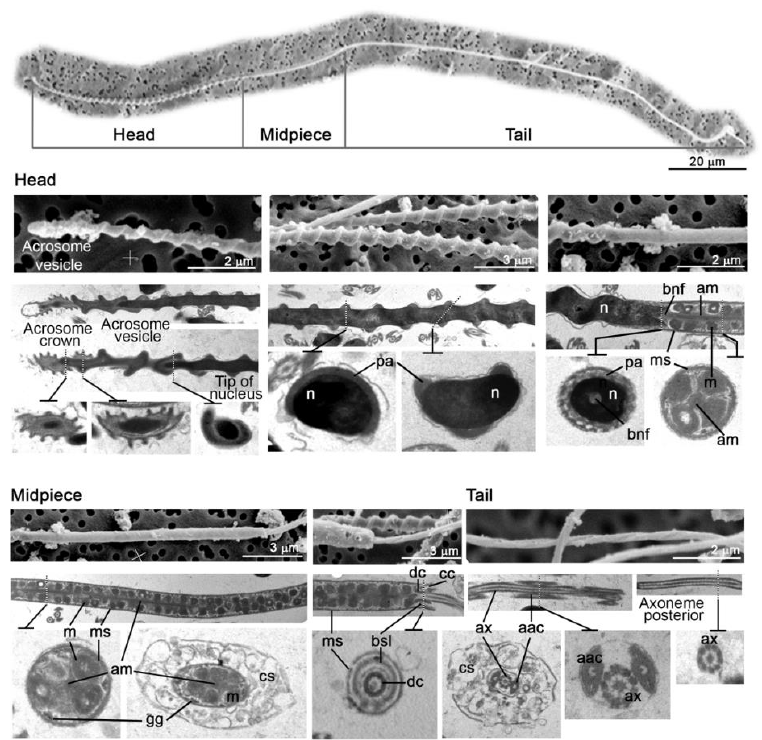
Figure 3. A representative image of ultrastructure of small-spotted catshark ( Scyliorhinus canicula ) sperm cells. Scanning and transmission electron micrographs of longitudinal and transverse sections through the main pieces of the spermatozoon. The top pictures were obtained with transmission electron microscopy, while the bottom pictures were obtained with scanning electron